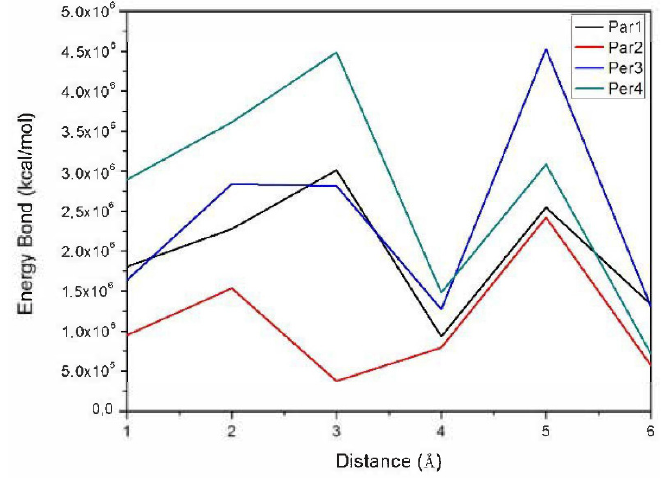
Figure 6. Evolution of energy values at different distances of the derivative ABT molecule and the feroxyhyte surface.